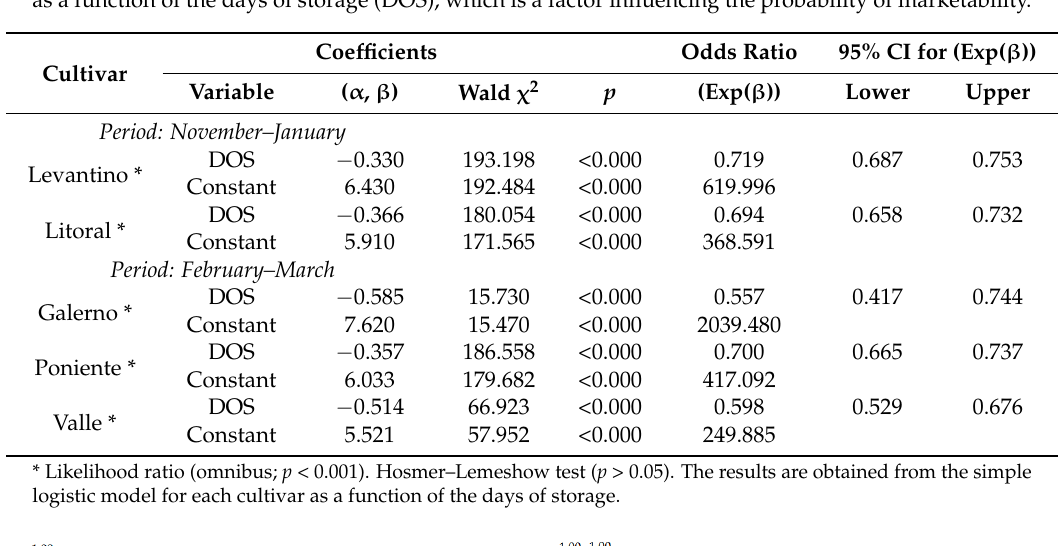
Table 2. Estimated independent simple logistic regression parameters for each LET cucumber cultivar as a function of the days of storage (DOS), which is a factor influencing the probability of marketability.